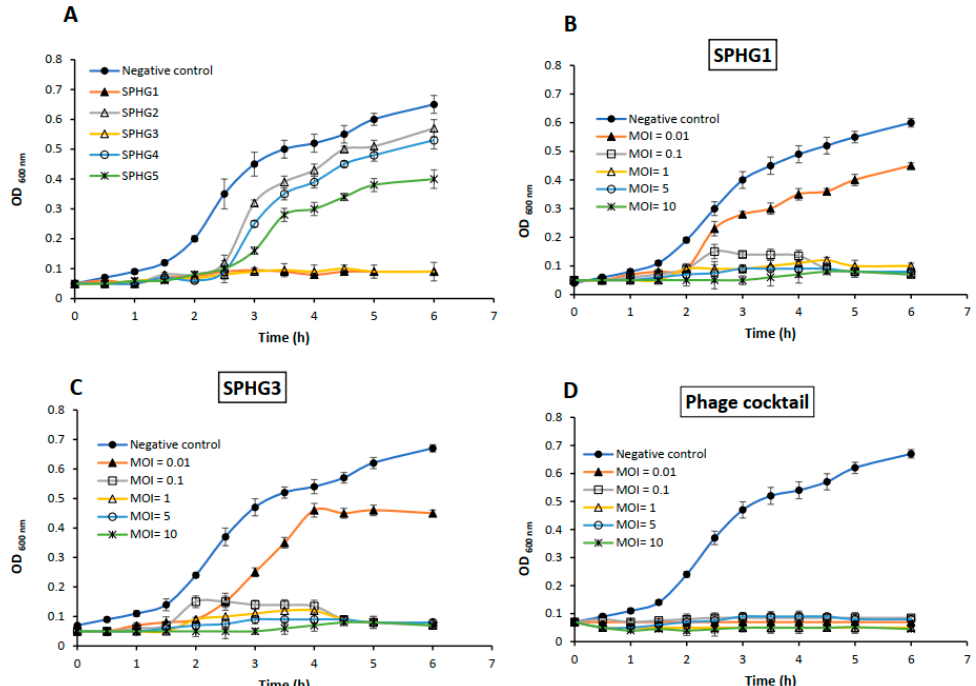
Figure 1. ( A ) Lytic ability of the five isolated phages on S. Typhimurium, EG.SmT3 as a host at multiplicity of infection (MOI) of 1 in TSB broth, ( B , C ) Lytic ability of phages SPHG1 and SPHG3, respectively to lyse S. Typhimurium EG.SmT3 in TSB medium at different MOIs of 10, 5, 1, 0.1, and 0.01 at 37 ◦ C, and ( D ) Lytic activity of a phage cocktail developed from phages SPHG1 and SPHGThe bacteria were challenged with the isolated phages at the designated MOI in 96-well microtiter plates and incubated at 37 ◦ C. The bacterial growth was estimated by measuring optical densities (OD 600 nm) up to 6 h post-infection. The data shown are the mean of three replicates and error bars show the deviation in the values.